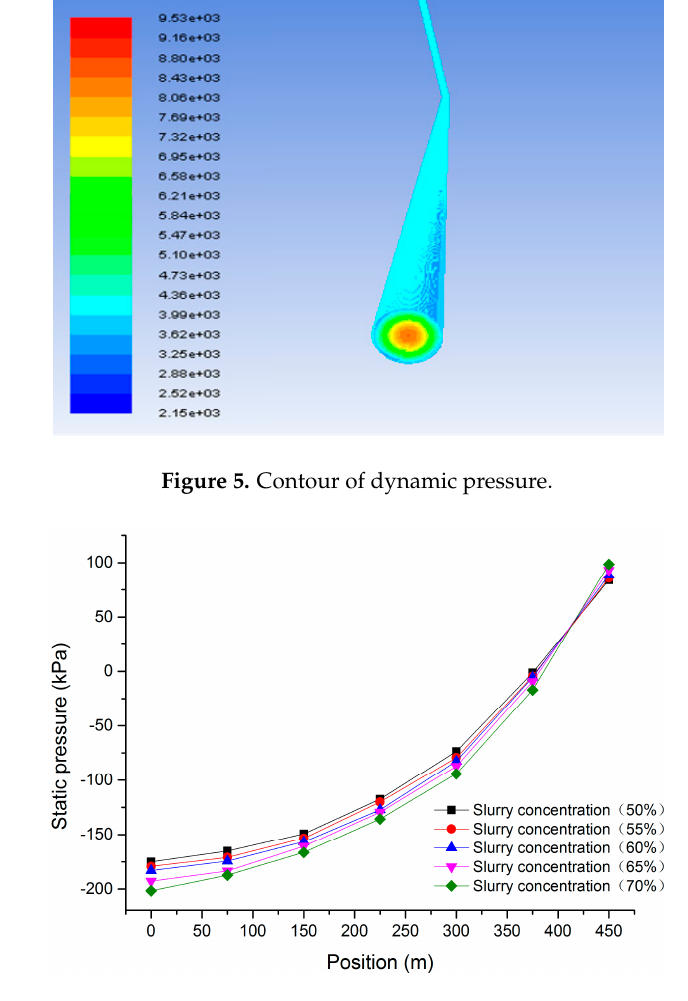
Figure 6. Conveying pressure distribution diagram of pipeline.